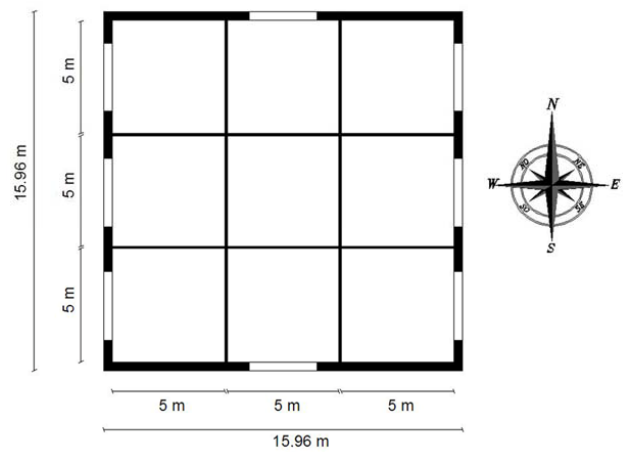
Figure 1. Case study plan.